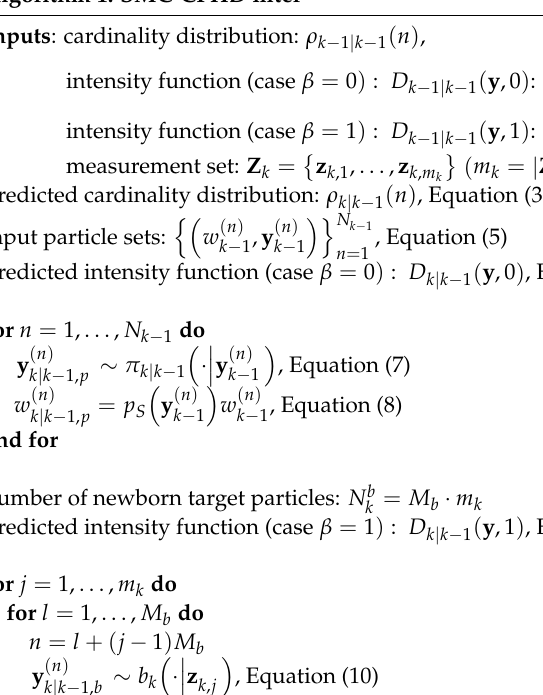
Algorithm 1: SMC-CPHD